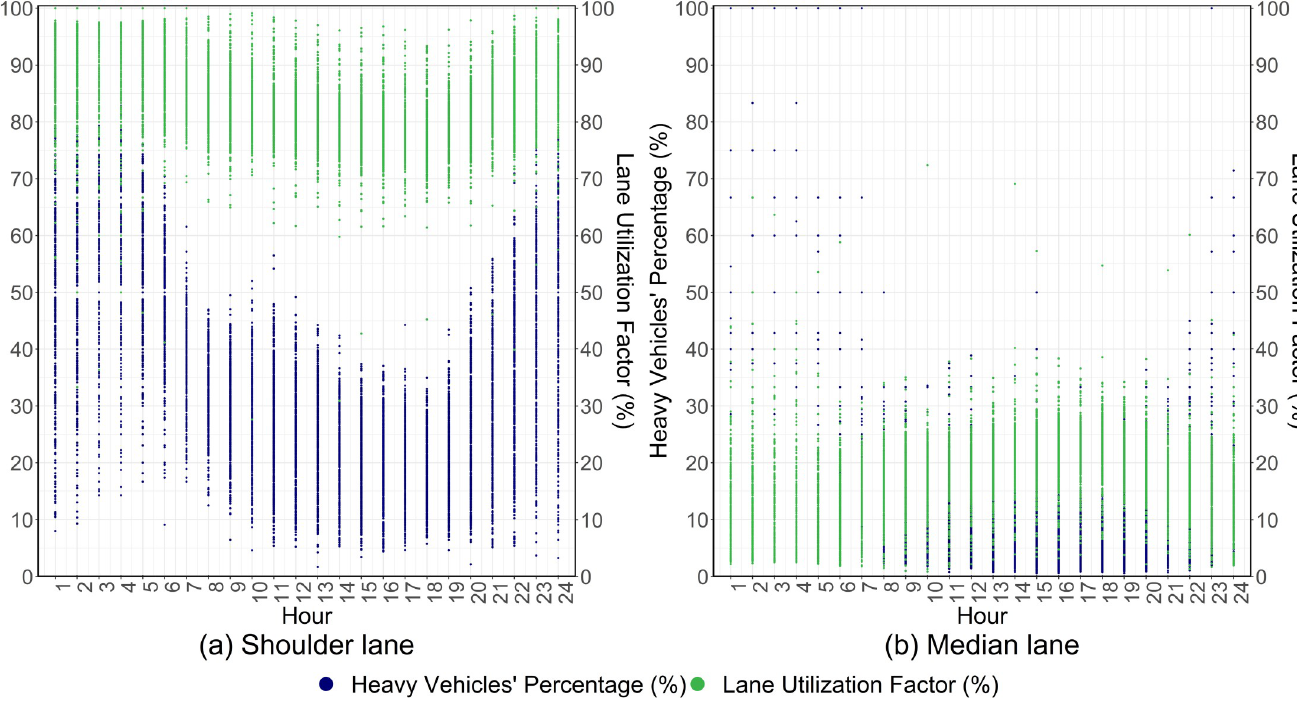
Fig 4. Hourly variation of the heavy vehicles’ percentage and the lane utilization factor at the study site.